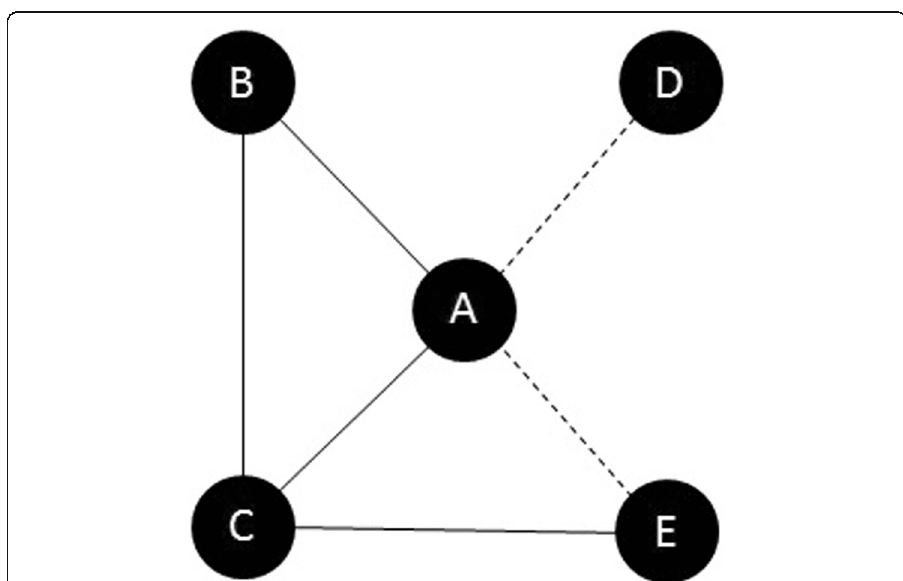
Fig. 1 A toy network with five nodes where solid and dotted lines represent respectively the positive and negative relations between